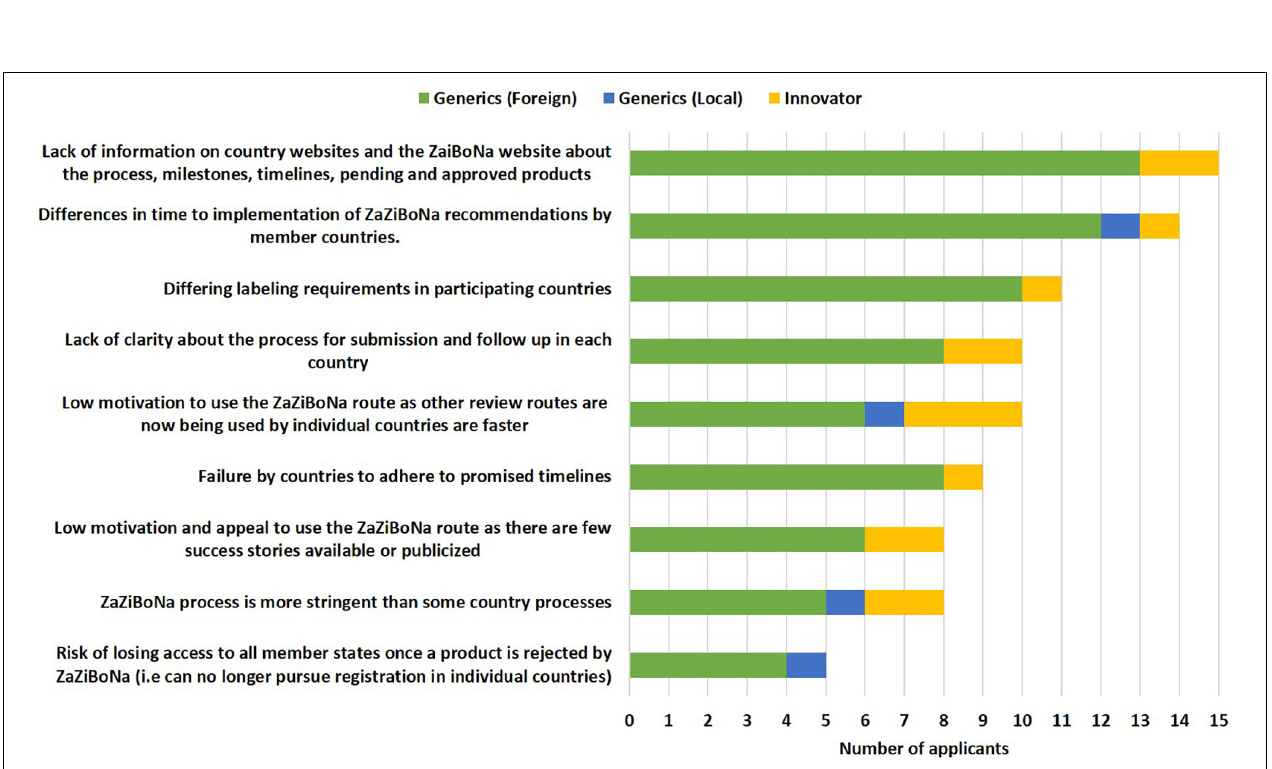
FIGURE 4 | Challenges to the ZaZiBoNa initiative for applicants according to pharmaceutical industry respondents.